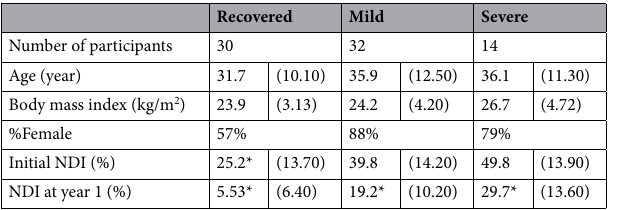
Tract Sum of squares df Mean